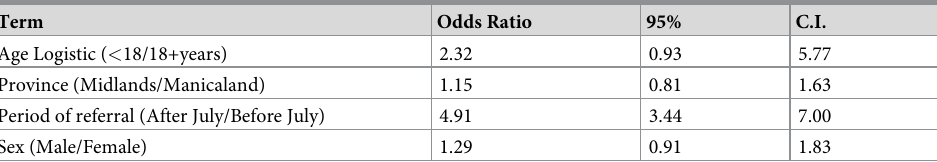
Table 2. Multivariate associations with linkage to care within seven